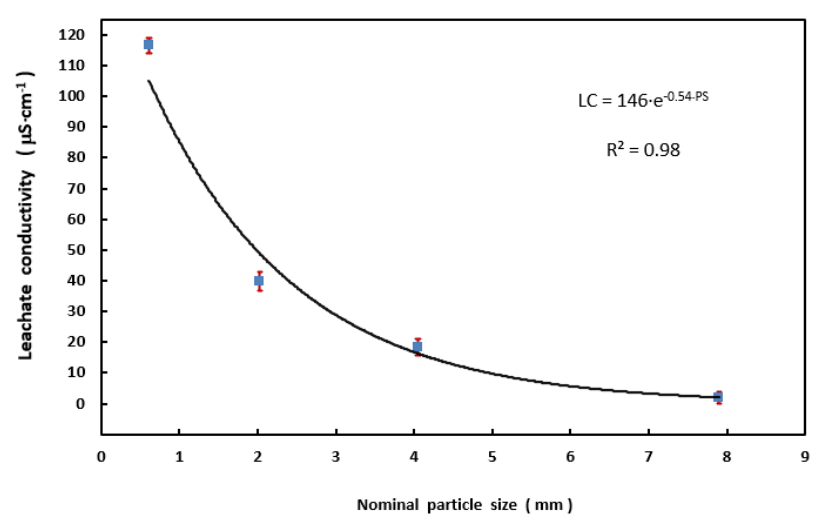
Figure 3. Leachate conductivity (LC) of the kernel fraction versus nominal kernel particle size (PS). Kernel fraction separated from 1X treatment in Experiment 4. Error bars represent the standard error and n = 8.